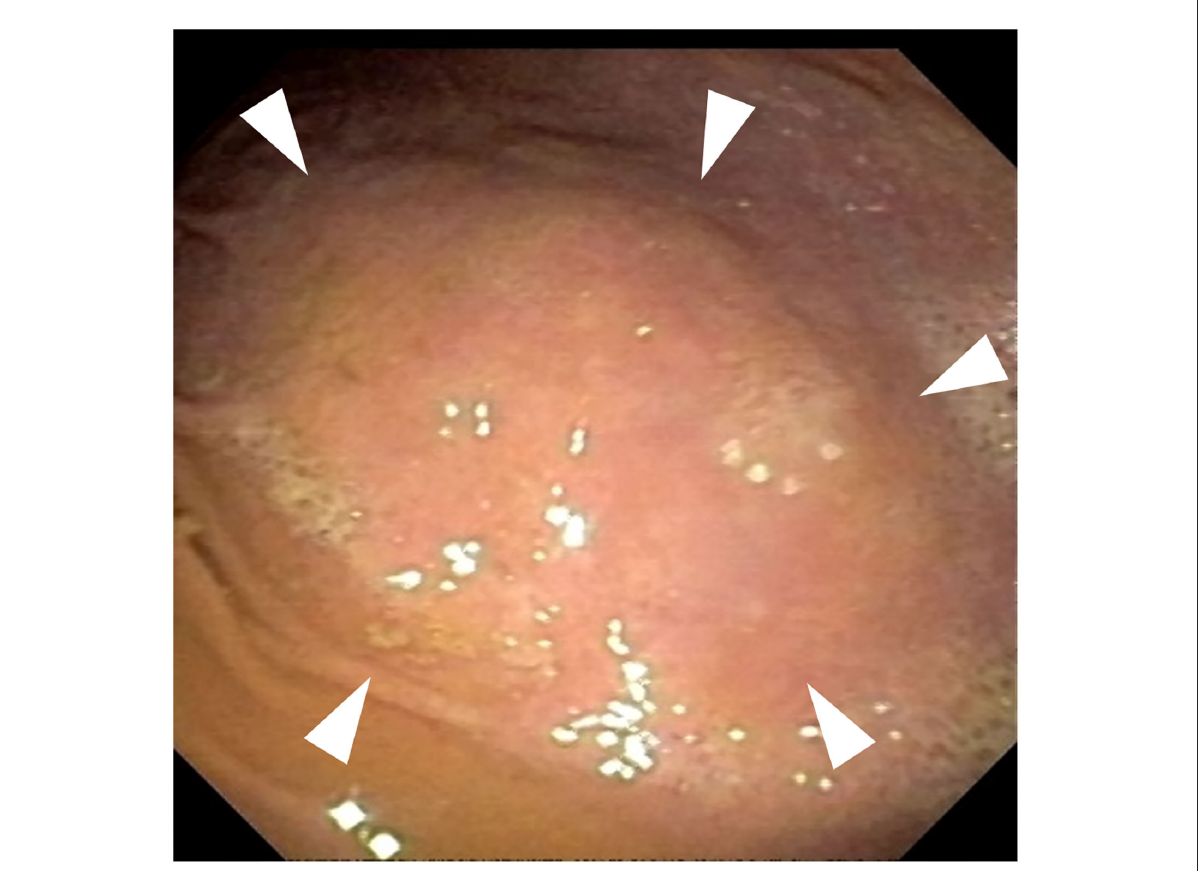
FIGURE2 Endoscopy of the fundic region of the stomach. Gross thickened areas (arrowheads) appear to be from the stomach wall and do not involve the gastric